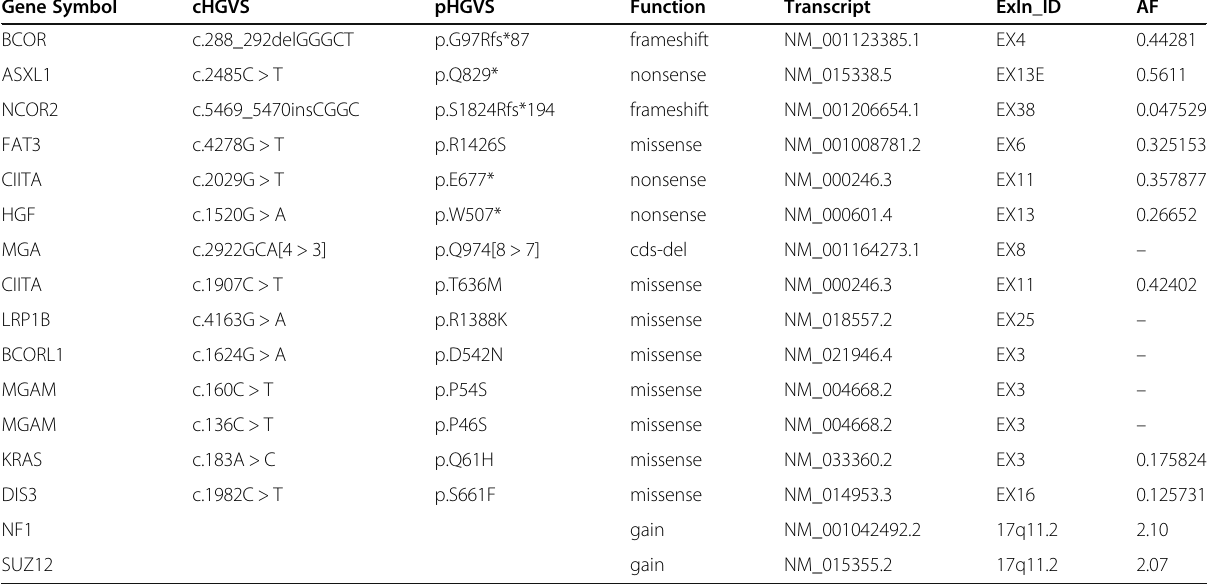
Table 2 Gene mutations detected by